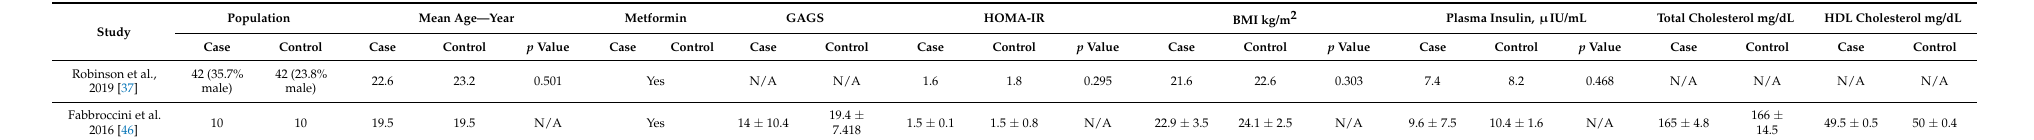
Table 1. Studies evaluating the efficacy and safety of Metformin in male patients affected by acne (GAGS: Global Acne Grading System, HOMA-IR: homeostasis model assessment-insulin resistance). Table 2. The GAGS: Global Acne Grading System explanation. (reference 47)